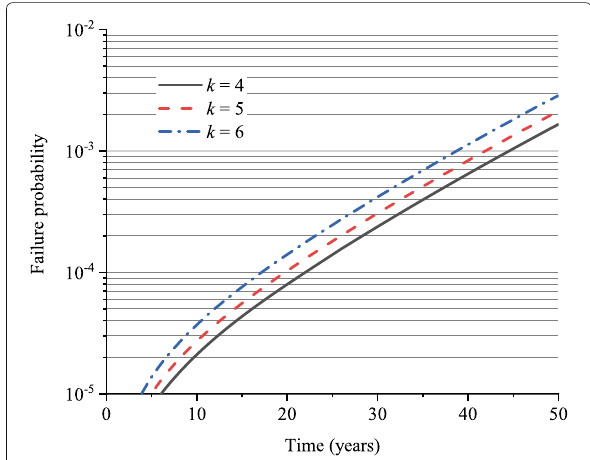
Fig. 5 Time-dependent failure probabilities of weighted k -out-of-5 systems for different k